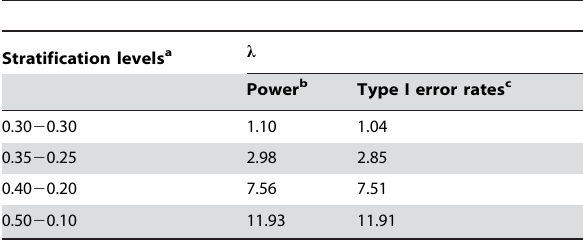
Figure 4. Performance of SA with numbers of AIMs varying from 40 to 200 (stratification level = 0.5 2 0.1, sample size = 1200 and frequency of disease susceptible al- lele=0.20 6 0.02).